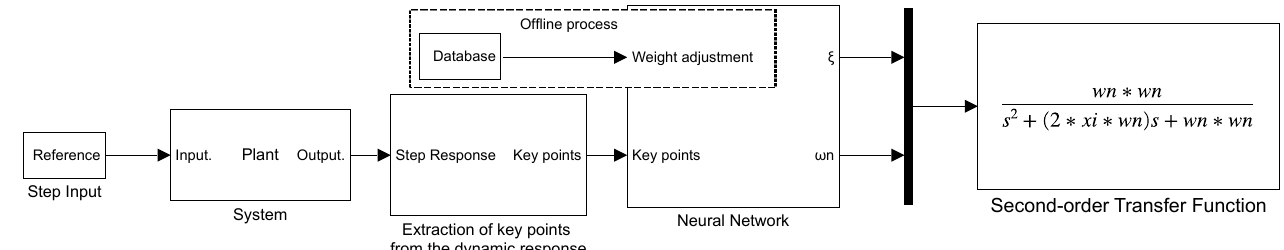
Figure 2. General process to implement the BP-ANN as parameter estimator of a Transfer